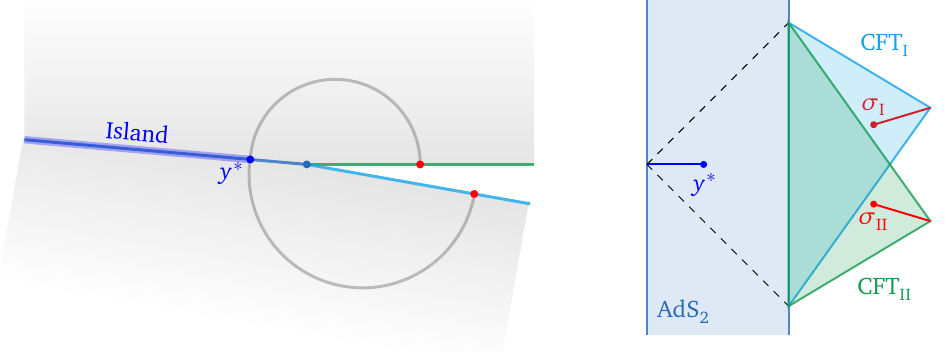
Figure 8: In the spirit of double holography we can interpret the geodesic of Figure 5 in a a two dimensional perspective. In particular we can integrate out the bulk degrees of freedom and consider the induced effective action on the brane. Then, the bulk geodesic can be interpreted as the island in the intermediate two dimensional picture. In particular, for large values of the tension, one can prove that the point where the geodesic of Figure 5 crosses the brane is the position where the island appears minimizing the 2 d generalized